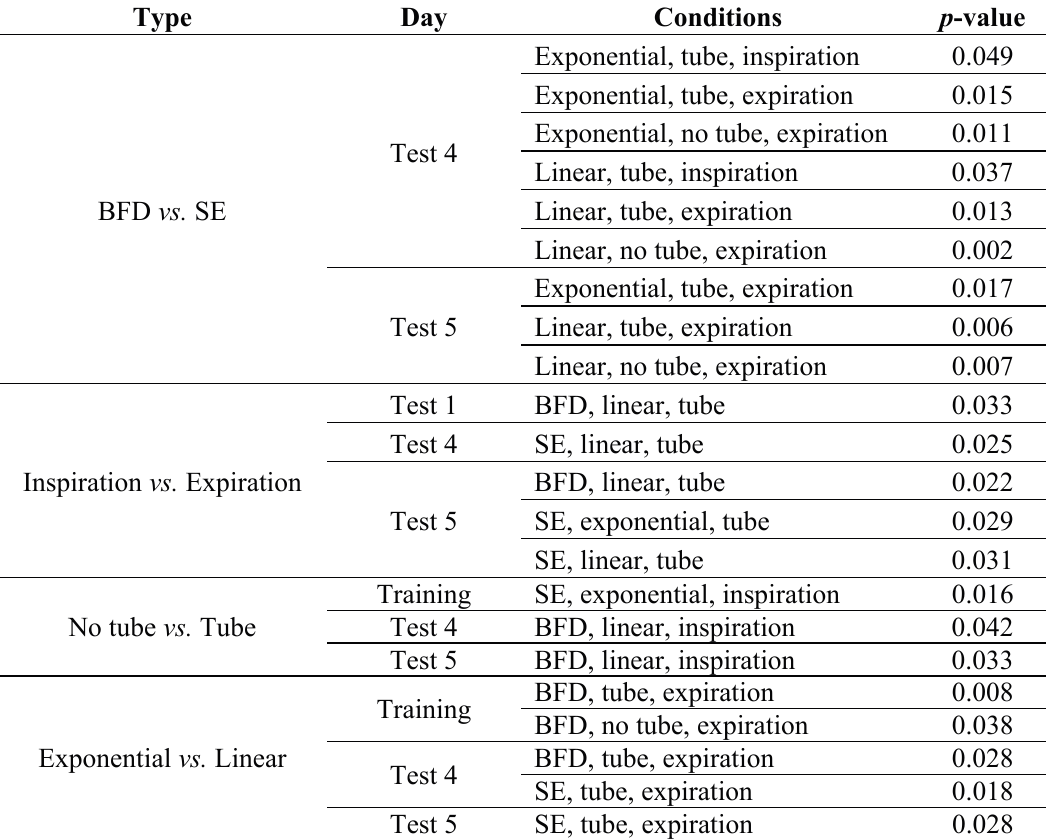
Table 1. Combinations of conditions when statistically significant differences were obtained, and their corresponding p -values. Results are grouped into 4 groups, based on the type of comparisons performed, i.e. , BFD vs. SE; inspiration vs. expiration; no tube vs. tube; exponential vs. linear